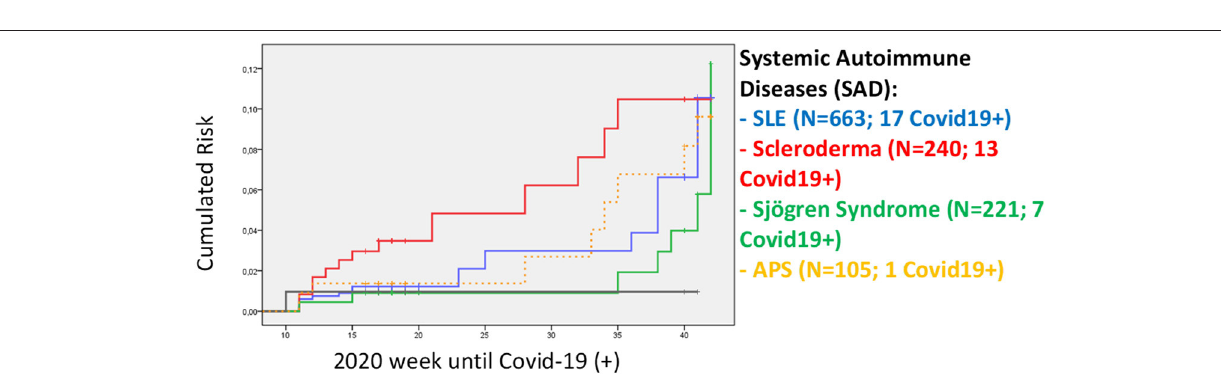
SARS-CoV-2 infection comparable to that observed in other European